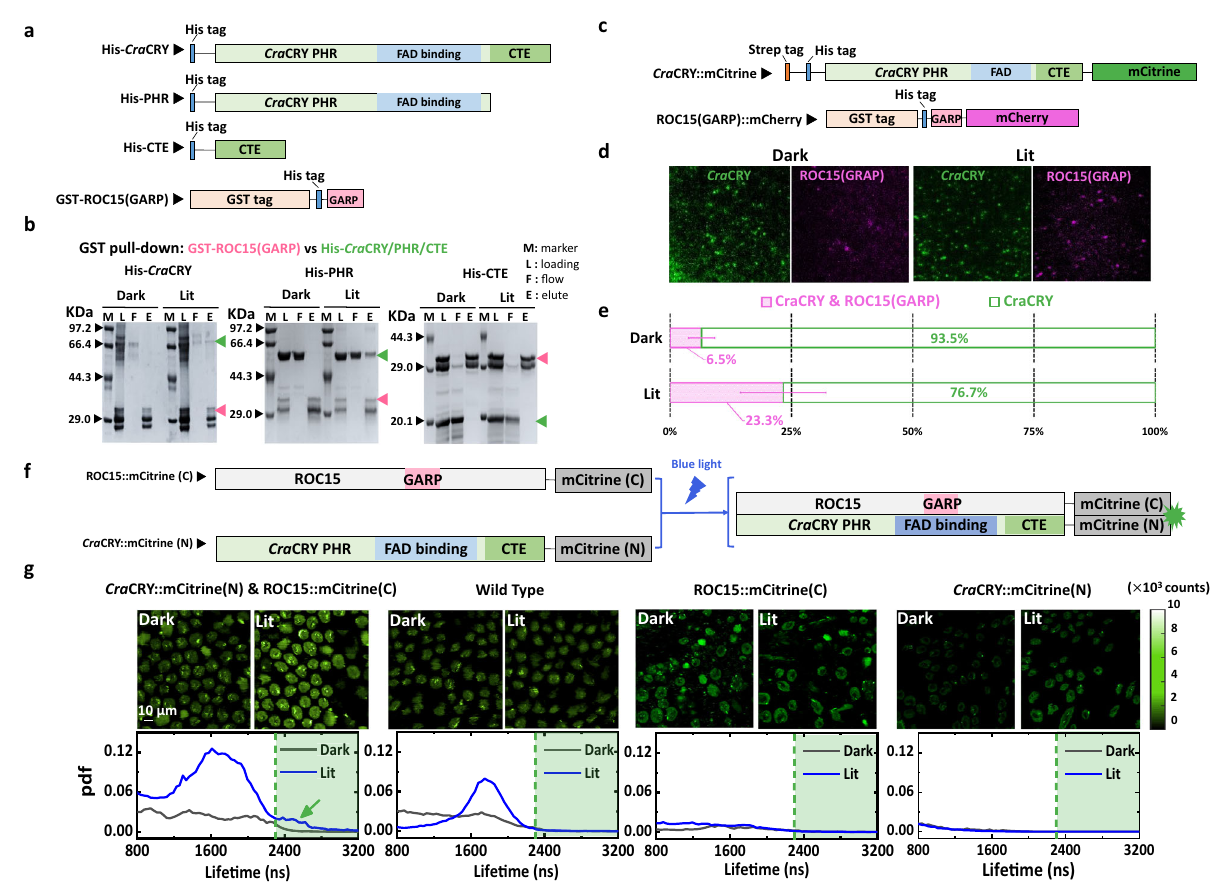
Fig. 3 Intermolecular interactions identi fi ed using pull-down and BiFC assays. a Schematic of protein construct design for the GST pull-down assays. His- tags were fused with full-length Cra CRY, the PHR domain, and the CTE domain. They were preyed on by GST-tag fused ROC15(GARP) as the bait protein. b Pull-down molecular complex analyzed using SDS-PAGE. The green arrows mark the band of wild-type Cra CRY (left), the PHR domain (middle), and the CTE domain (right). The pink arrows mark the band of ROC15(GARP). c Protein construct design for single-molecule pull-down assays. Fluorescence proteins mCitrine and mCherry are fused with full-length Cra CRY and ROC15(GARP), respectively. As the bait protein, Strep-tag-fused Cra CRY::mCitrine is tethered to the glass slide by streptavidin. d Total internal re fl ection fl uorescence microscopy (TirfM) images of single-molecule pull-down assays. Green and magenta points are the fl uorescent signals emitted from Cra CRY::mCitrine and ROC15(GARP)::mCherry, respectively. e Statistics of the colocalized molecules in single-molecule pull-down assays. The colocalization fractions of Cra CRY::mCitrine and ROC15(GARP)::mCherry complex under dark and lit conditions are shown as magenta bars, whereas green bars indicate the fractions of protein complex containing only Cra CRY. The error bars are the statistical standard deviation, seeing Supplementary Table S3 for exact values. f Sketch map of protein designs and principles for BiFC assays. Upon blue- light illumination, the binding between Cra CRY and ROC15 triggered the recombination of mCitrine(N) and mCitrine(C), and the fl uorescence signal of mCitrine was detected using fl uorescence-lifetime imaging microscopy (FLIM). g Fluorescent images (upper) and lifetime distributions (lower) of single- and double-transfected and wild-type C. reinhardtii cells under the dark or lit condition. Fluorescent intensity images are shown in green. Gray and blue lines indicate the lifetime distributions for each image under the dark and lit conditions, respectively. The green arrow points to the characteristic lifetime component of mCitrine